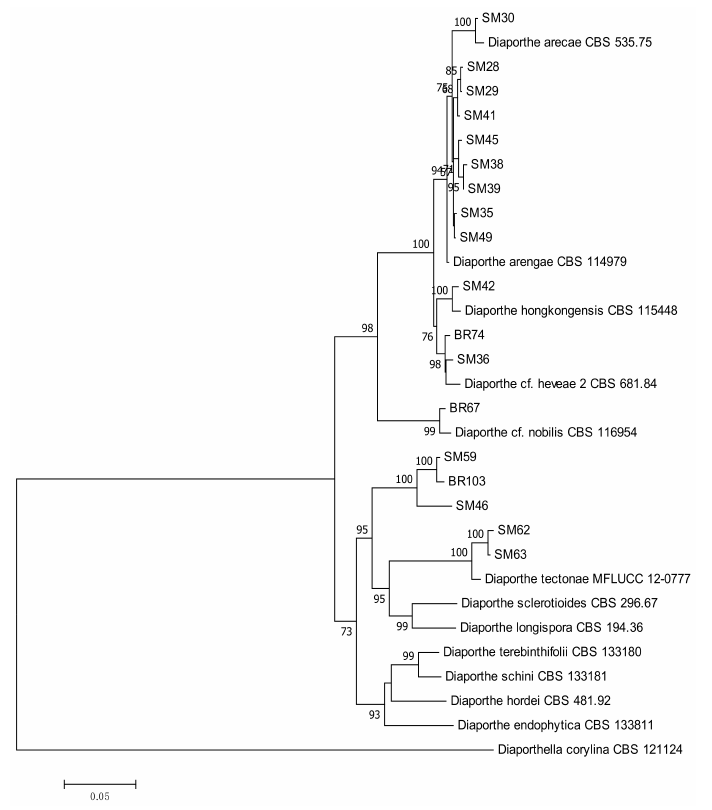
Figure 3. Maximum likelihood tree inferred from combined sequences of ITS, TEF-1 α , and β -tubulin of Diaporthe isolates from C. castaneus spines with bootstrap values higher than 50% are shown next to the